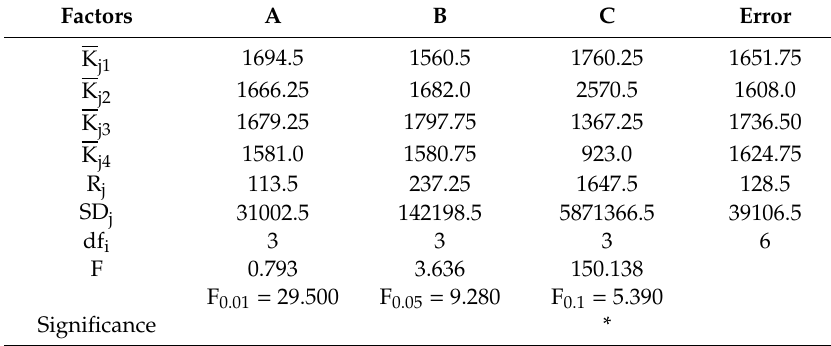
Table 5. Range analysis for tensile